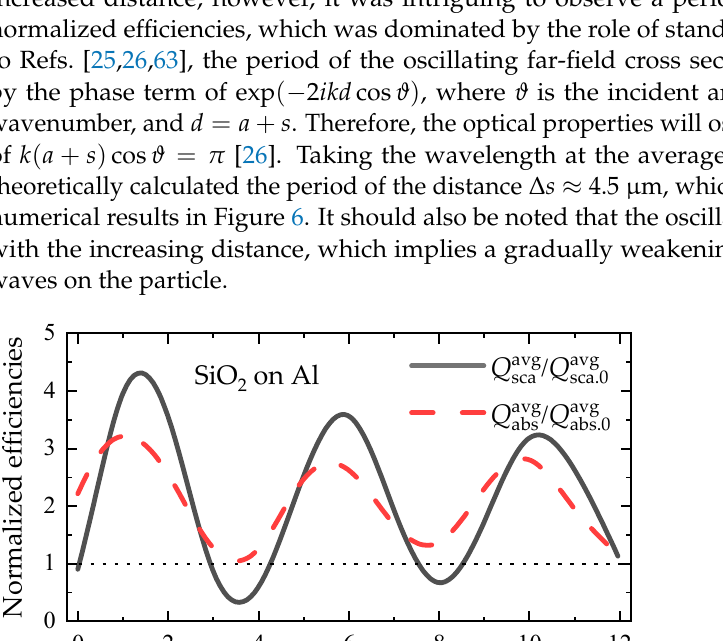
Figure 6. The wavelength-averaged efficiencies of the SiO 2 particle on the Al substrate versus the particle-to-substrate distance s . Both the scattering Q avg sca and absorption efficiencies Q avg are averaged over the spectral range of 8–14 µ m. Note that the averaged efficiencies with the substrate are normalized with those without the substrate Q avg sca,0 , Q avg abs,0 The strongly regulated efficiencies by the Al substrate suggest that the replacements of Q sca , Q abs with Q sca,0 , Q abs,0 should be careful within the featured s range in practical applications. For example, both average efficiencies considering the substrate suppress those in the free space over the almost whole range of s = 0–12 µ m. Thus, even if the realistic SiO 2 particles distributes randomly over the Al substrate, a distance-averaged efficiencies of the particle system still deviate largely from those in free space. This implies that the effects of the substrate should be further considered in the radiative property prediction by solving RTE in the particle-dispersed